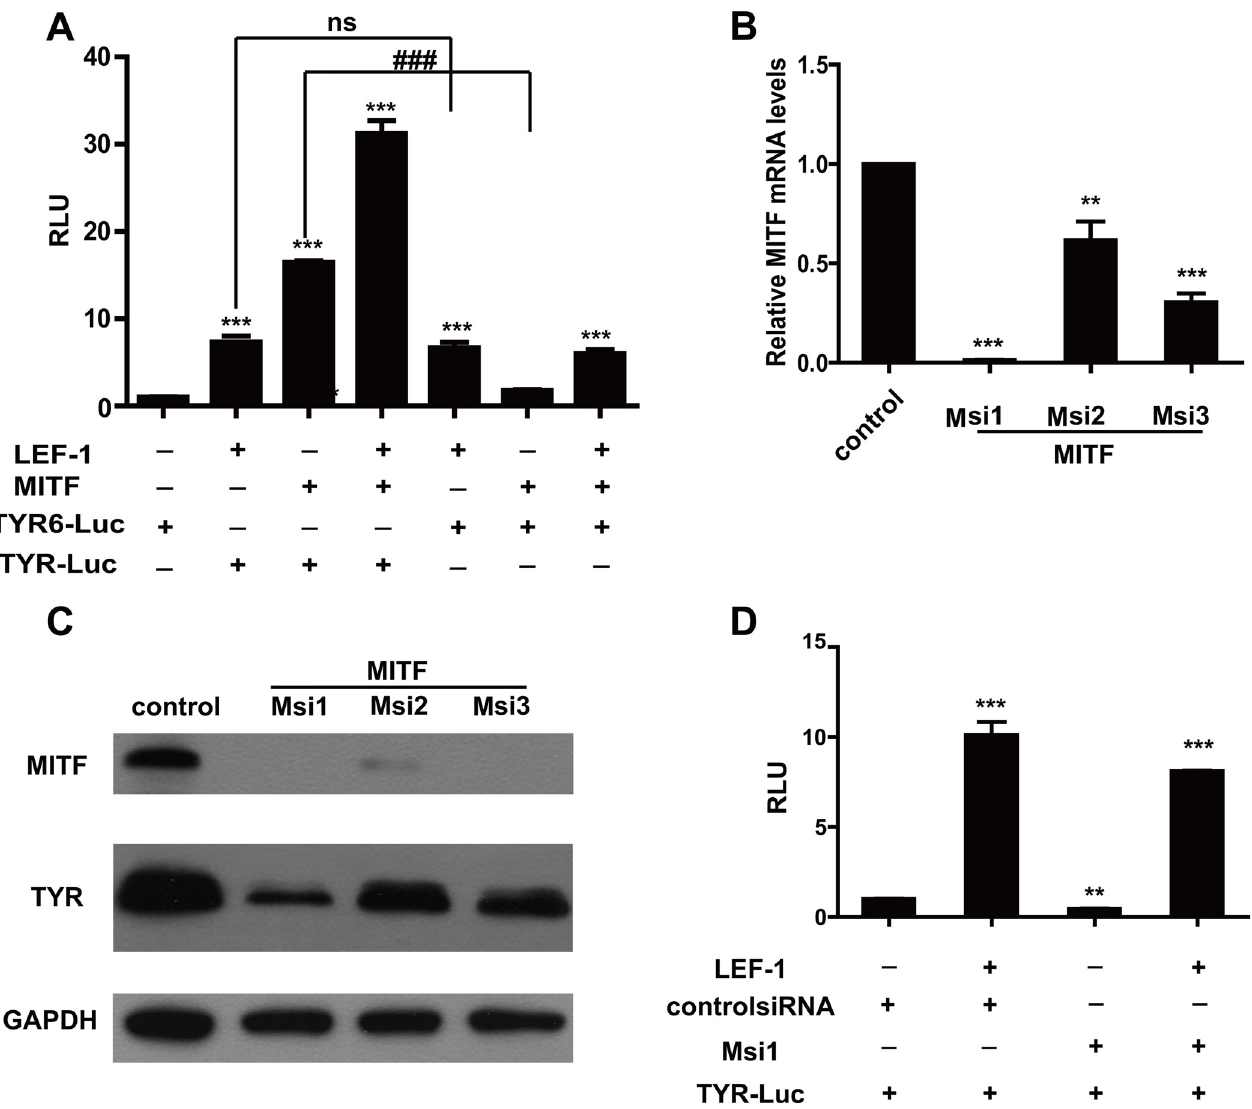
Fig 5. LEF-1 independently regulates TYR expression. A LEF-1-mediated tyrosinase promoter activity determined by luciferase activity assay when MITF expression was inhibited. UACC903 cells were co-transfected with the indicated promoter reporter plasmid and effector plasmid (s). A luciferase assay was performed 48 h after transfection. Relative luciferase activities are expressed as the mean ± SD from three independent experiments each performed in triplicate. ( *** p < 0.001, compared to the value from the TYR6 promoter and empty vector; ns, not significant, ###p < 0.001, compared to WT;